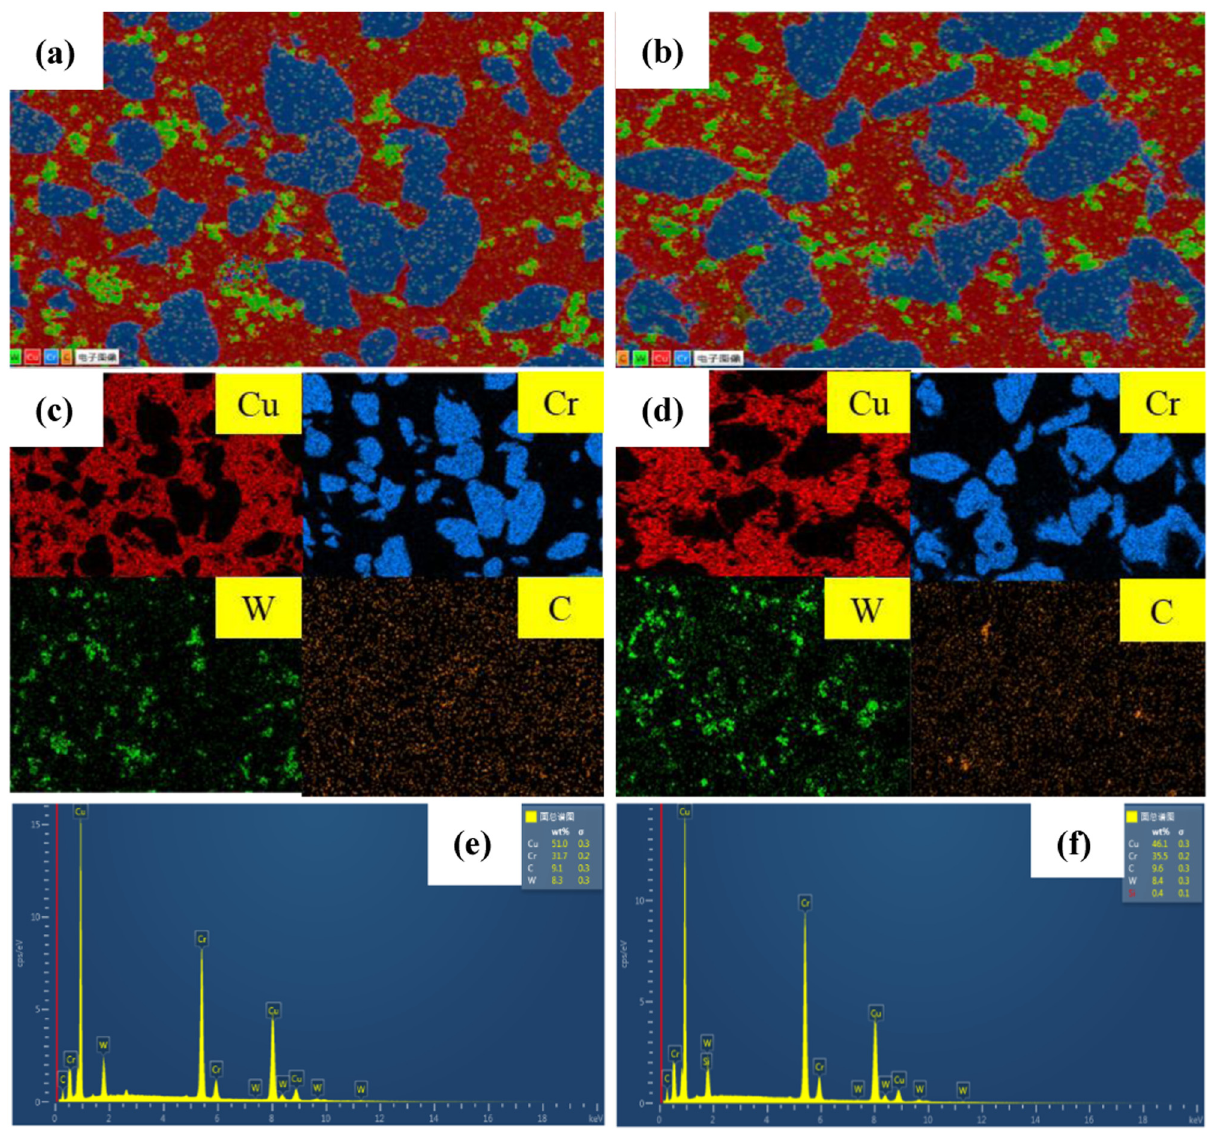
Figure 5: SEM images and corresponding EDS maps of the two composites: ( a, c, and e ) 0.5GO/0.5CeO 2 – Cu30Cr10W; ( b, d, and f ) 1.0GO/ 0.5CeO 2 –